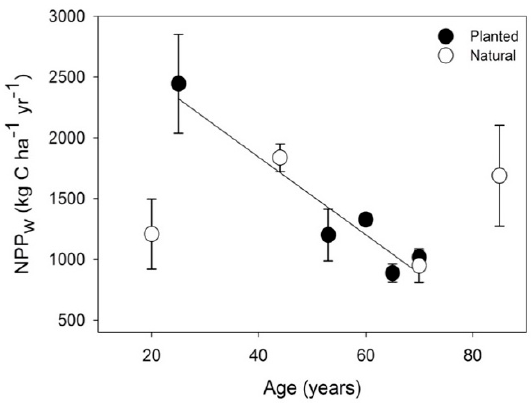
Figure 2. Mean annual wood net primary production (NPP w ; ± SE, n = 3) in relation to the stand age of planted pine and naturally regenerated red pine dominated stands. The solid regression line denotes a significant ( p < 0.05) reduction in the planted pine with age ( r 2 =